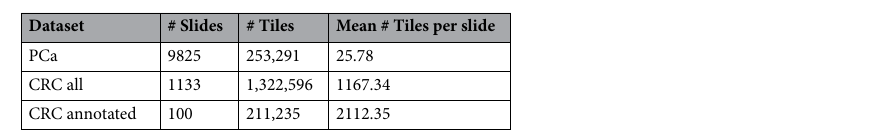
Table 4. Comparison between the number of tiles extracted from the PCa slides and the CRC